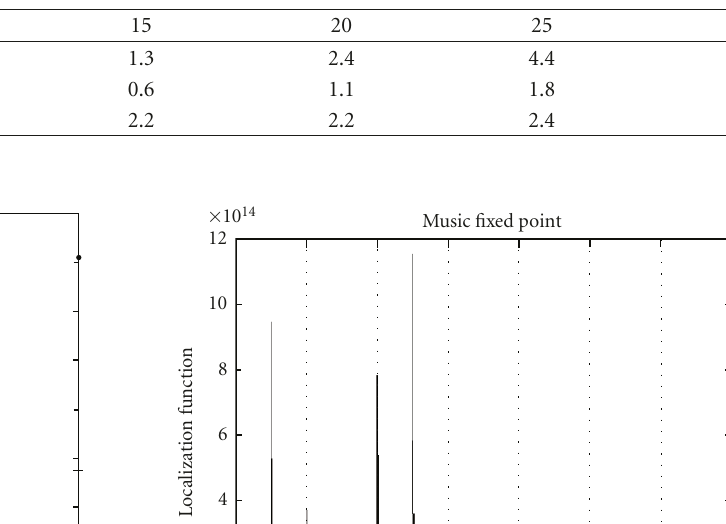
Table 1: Computational time needed to run MUSIC, using SVD and fixed point, for various numbers of sensors.